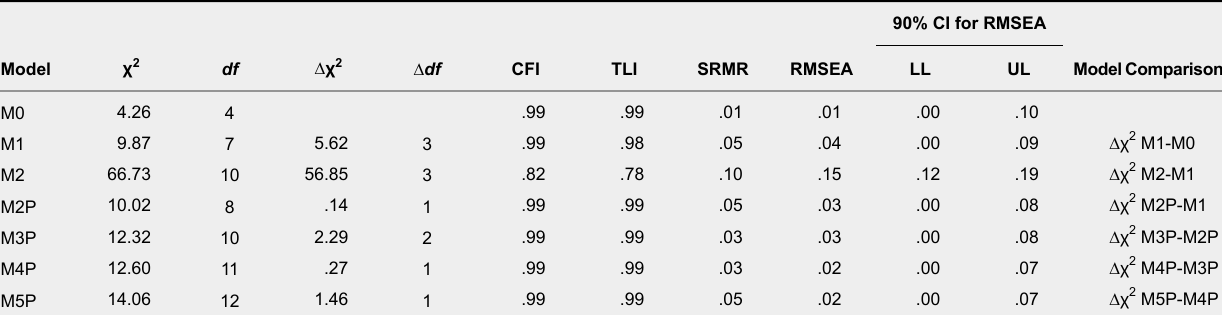
Goodness-of-fit Indices and Comparison of Models Testing Measurement Invariance for Legitimacy of Protests (Original Scale)